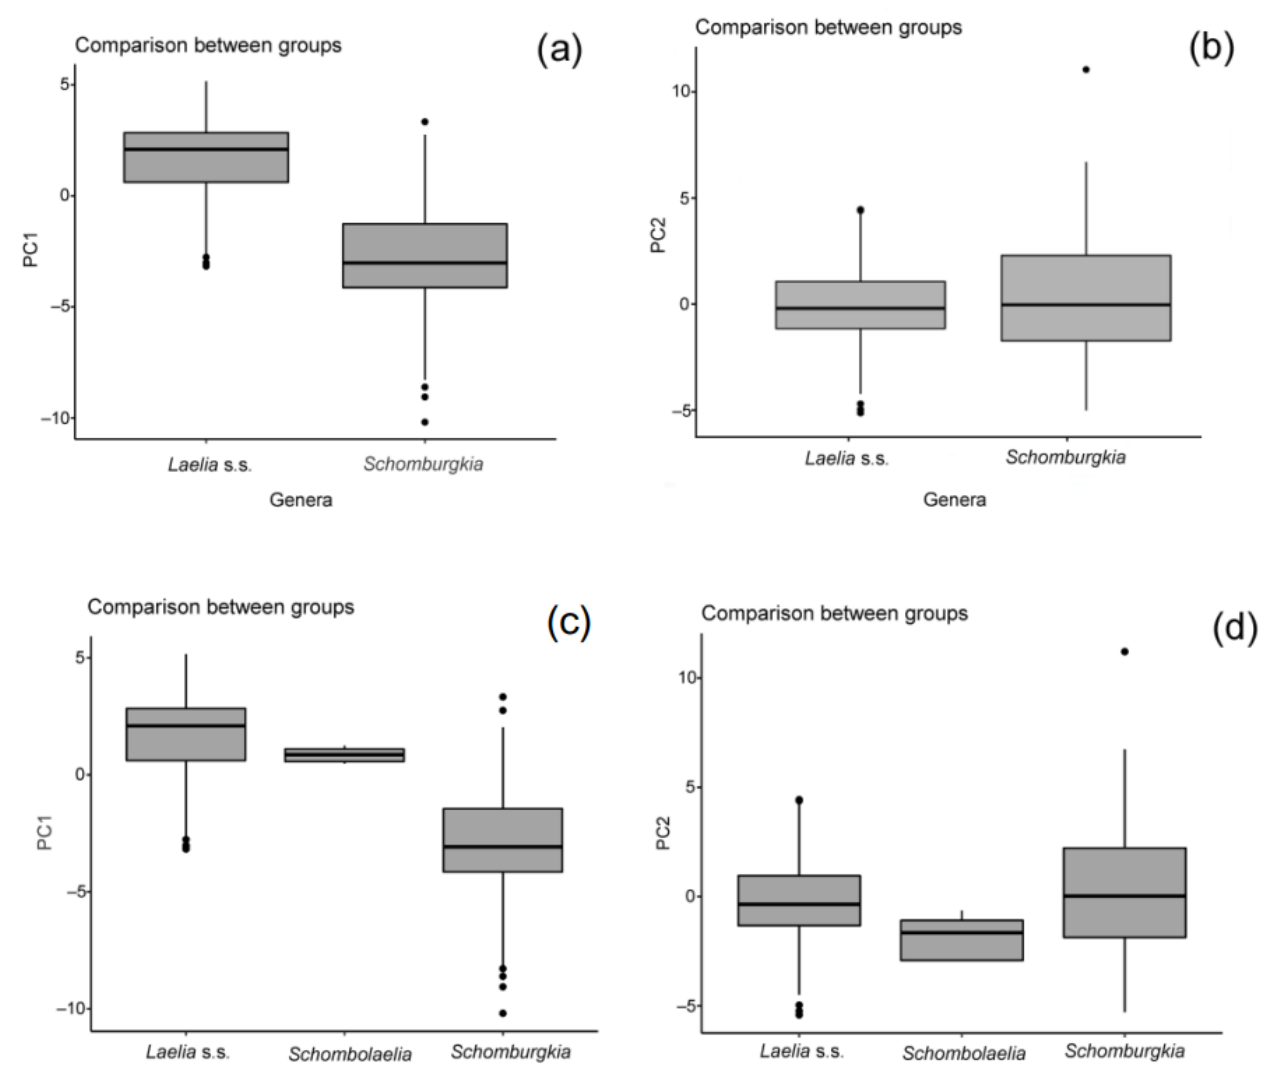
Figure 8. Comparison of means between genera by principal component by Tukey’s method, applying the Bonferroni adjustment between Laelia s.s. and Schomburgkia : ( a ) component 1; ( b ) component 2. Com- parison of means between genera by principal component by Tukey’s method, applying the Bonferroni adjustment between Laelia s.s., Schombolaelia , and Schomburgkia : ( c ) component 1; ( d ) component 2. When × Schombolaelia gouldeana was included in the PCA (Figure 7b), it was grouped within the convergence space between Laelia s.s. and Schomburgkia . According to the ANOVA ( p = < 2 × 10 − 16 ) and ANOSIM (R = 0.6062, p = 0.0001), significant differences were detected. These differences were identified as occurring between × Schombolaelia and Schomburgkia , as well as between Laelia s.s. and Schomburgkia in PC1, and only between Laelia s.s. and Schomburgkia in PC2 (Table 4, Figure